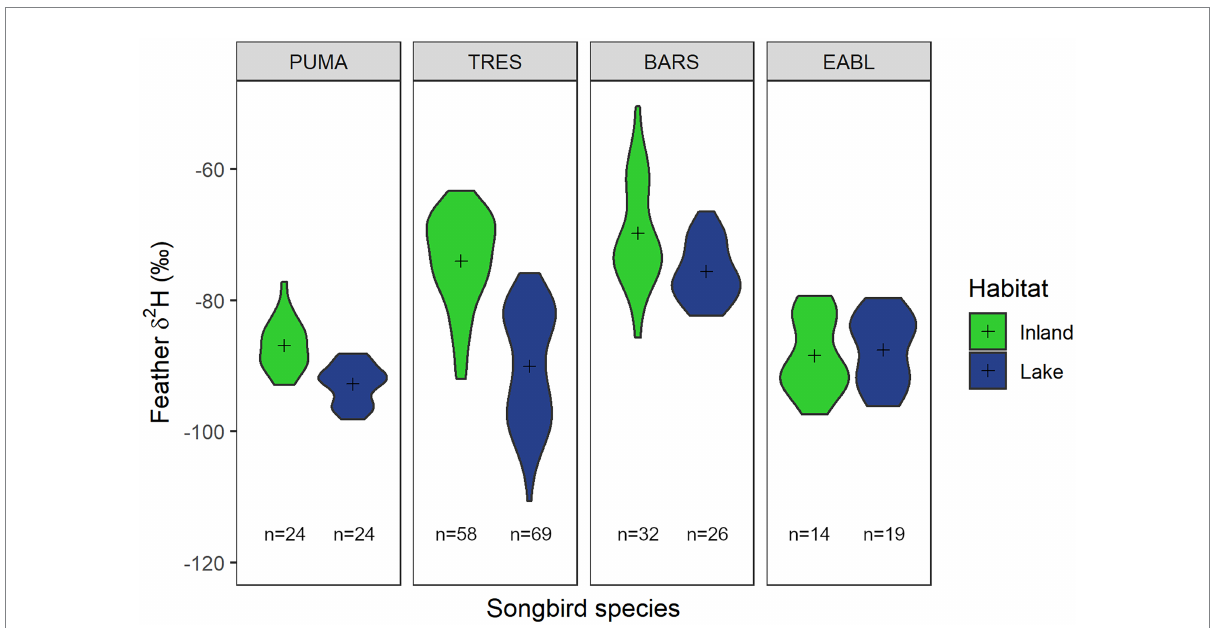
FIGURE 2 Violin plot showing the distribution of feather δ 2 H values (‰) from purple martin (PUMA), tree swallow (TRES), barn swallow (BARS), and eastern bluebird (EABL) nestlings from inland (green) or lakeshore (blue) sites. Sample sizes are as shown on the plot and means are represented by (+) symbol.